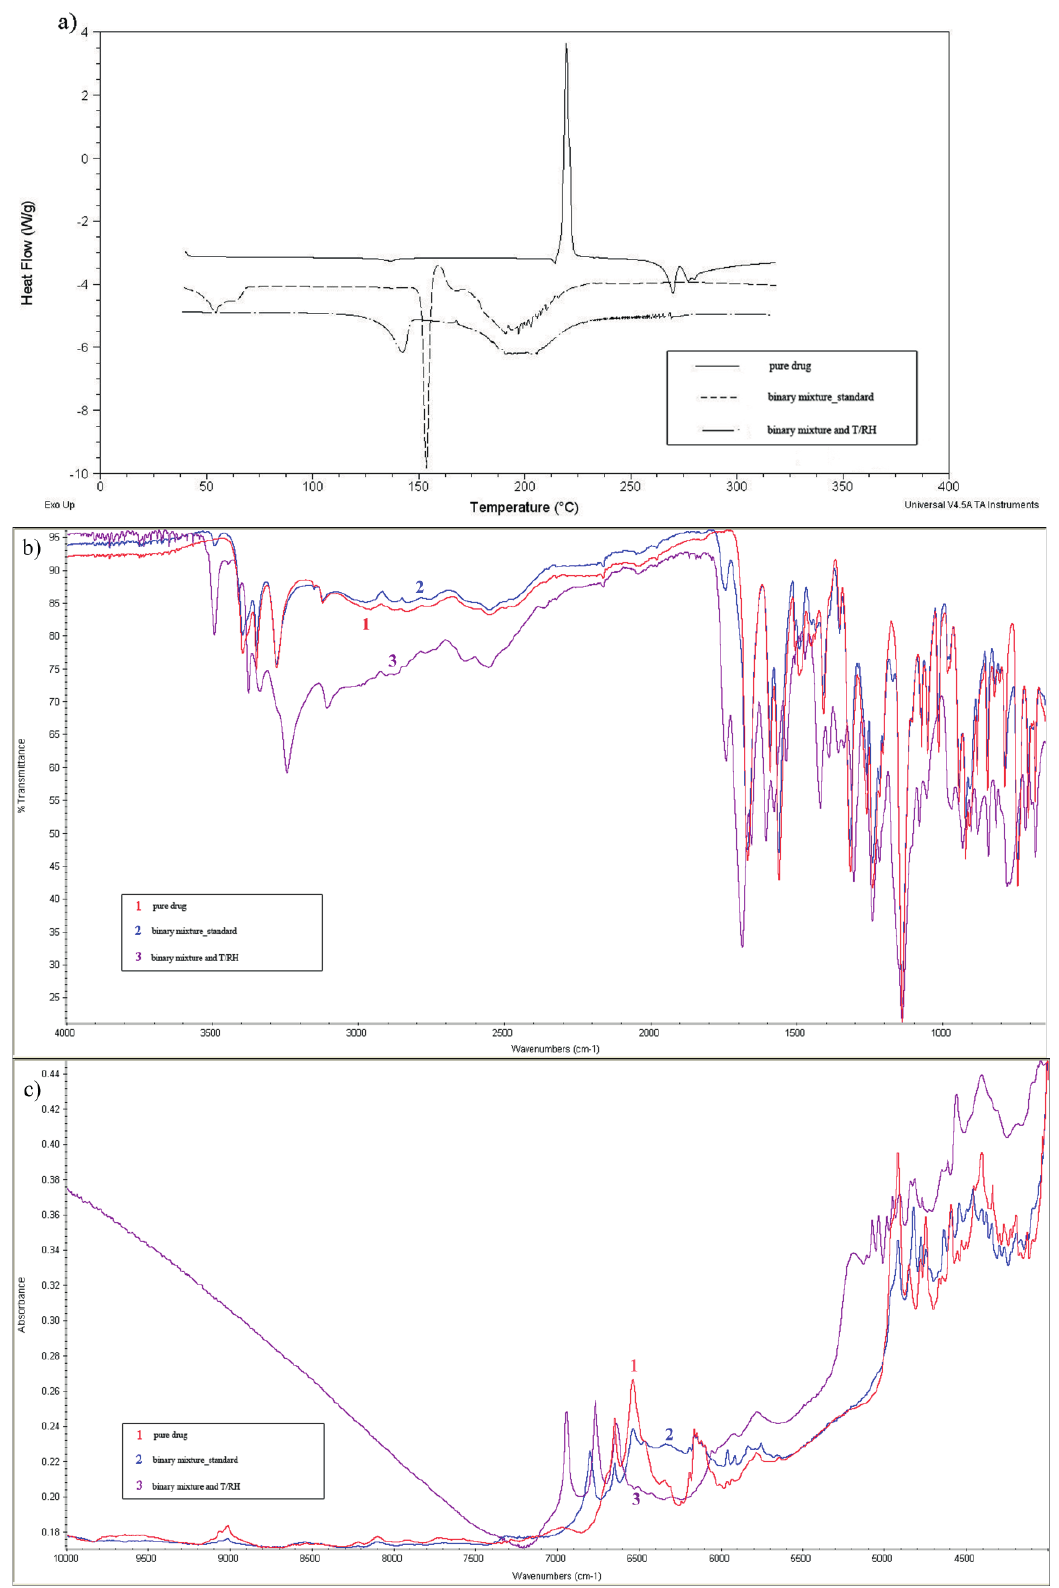
Figure 2 : Furosemide and citric acid: DSC scans (a), FT-IR spectra (b) and NIR spectra (c) for the mixture stressed with high temperature/ humidity (T/RH) and the untreated mixture (standard) against pure